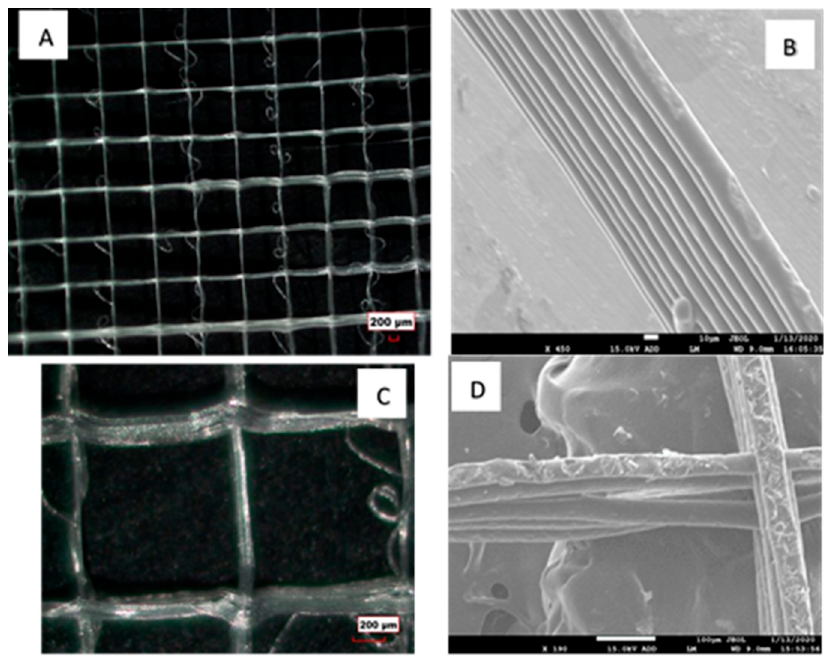
Figure 1. ( A ) Optical microscope image of the polycaprolactone (PCL) fibers printed as grid structures using melt electrospinning writing method; ( B ) scanning electron microscope (SEM) image of the cross-section of the grid structure (scale bar 10 μ m). The fibers are deposited on top of each other in a controlled manner; ( C ) optical microscope image of the PCL fibers demonstrating the cross-over points of the grid structures; and ( D ) SEM image demonstrating the surface morphology of the fibers (scale bar 100 μ m).